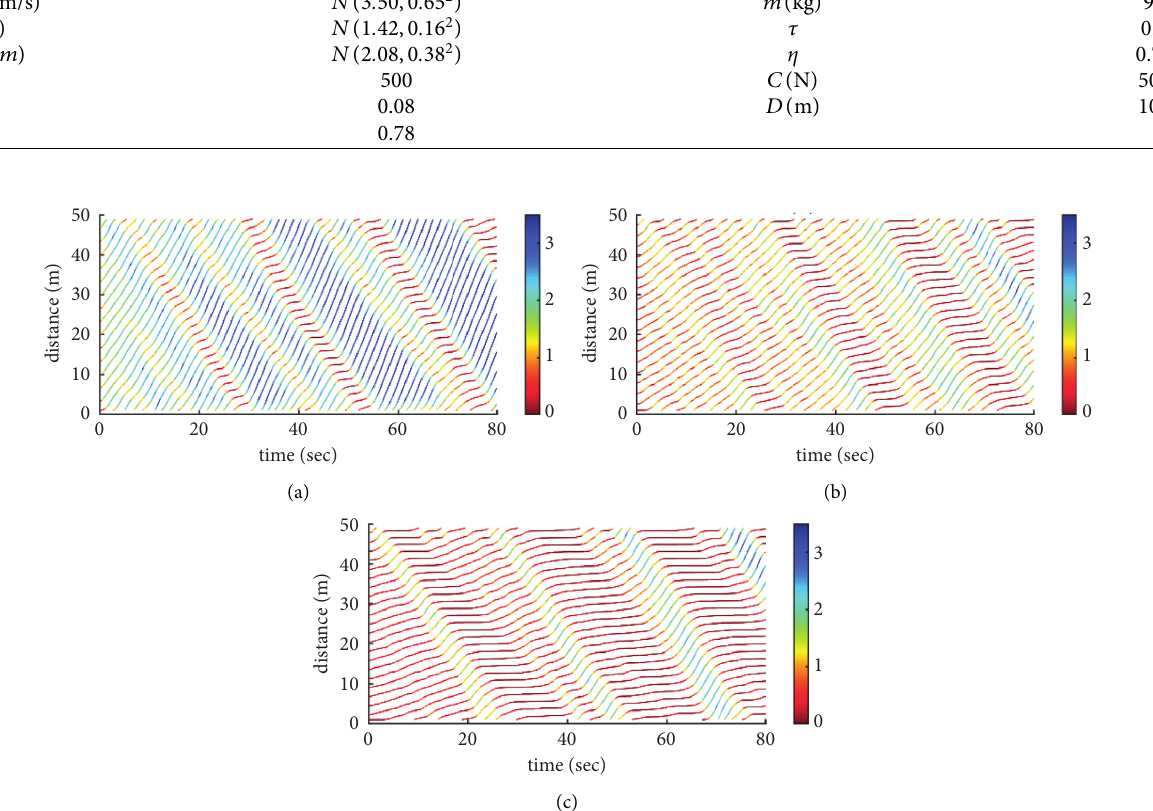
Figure 5: Each bicycle’s trajectory on the middle lane in Case I where the fixed numbers of bicycles on each lane in (a), (b), and (c) are, respectively, 15, 19, and 23. (a) N � 15. (b) N � 19. (c) N �